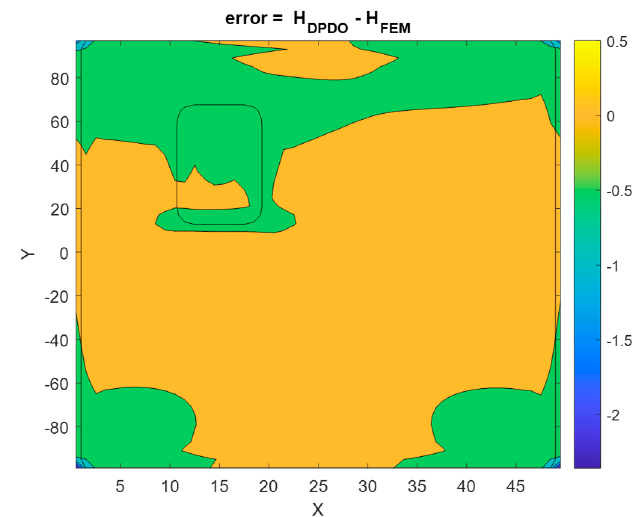
Figure 11. Difference between magnetic field ( , ) H x y resulting from DPDO and FEM. Figure 11. Di ff erence between magnetic field H ( x , y ) resulting from DPDO and